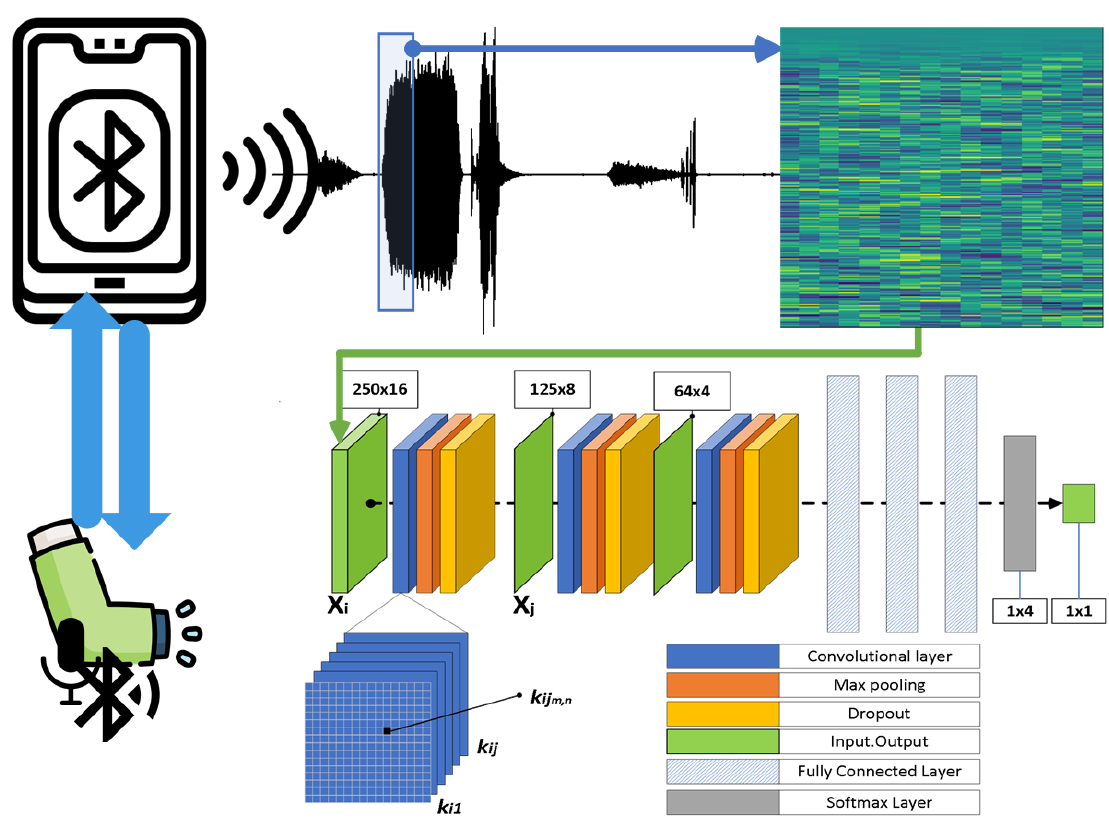
Figure 2. Overview of the processing pipeline.